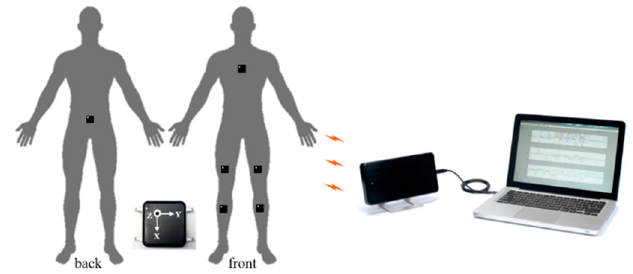
Figure 4. Schematic view of the sensor attachment on the participants and the wireless transfer of the laptop.